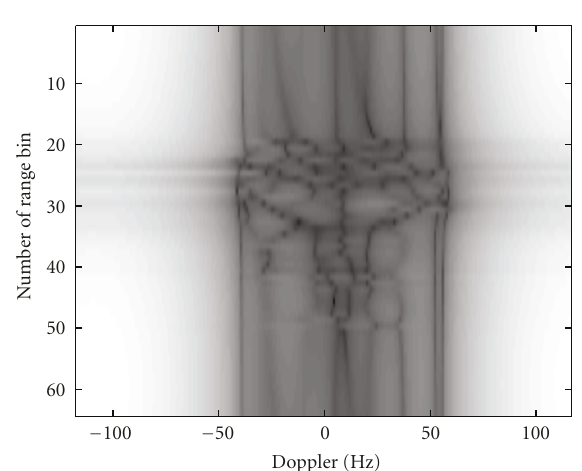
Figure 6: ISAR image obtained by applying AR coe ffi cients to the simulated data.